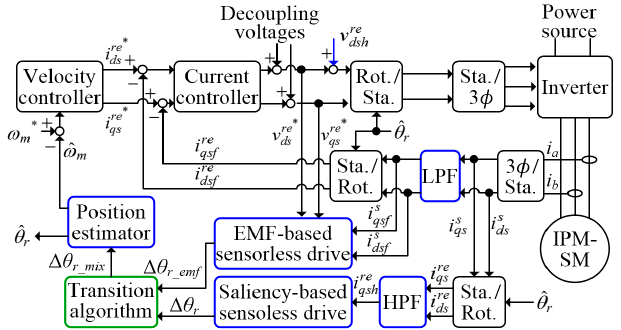
Figure 1. Overall control system for the full-speed region sensorless speed drive.